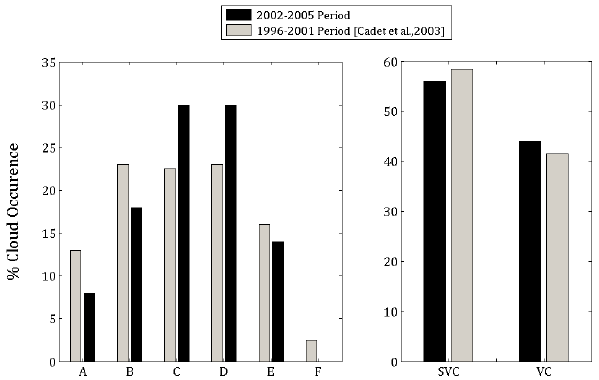
Fig. 9. Histograms of cirrus optical thickness binned on a log scale. Figure 9. Histograms of cirrus optical thickness binned on a log scale. Lettering along the 2 Lettering along the abscissa (left panel) corresponds to the fol- abscissa (left panel) corresponds to the following optical thickness intervals: A=(0.001- 3 lowing optical thickness intervals: A=(0.001–0.003), B=(0.003– 0.01), C=(0.01–0.03), D=(0.03–0.1), E=(0.1–0.3), F=(0.3–1.0). 0.003), B=(0.003-0.01), C=(0.01-0.03), D=(0.03-0.1), E=(0.1-0.3), F=(0.3-1.0). The right 4 The right panel shows the combined results according to subvisible panel shows the combined results according to subvisible cirrus (SVC) and visible cirrus 5 cirrus (SVC) and visible cirrus (VC). Categories A–C comprises the (VC). Categories A-C comprises the SVC component and D-F comprises the VC component. 6 SVC component and D–F comprises the VC